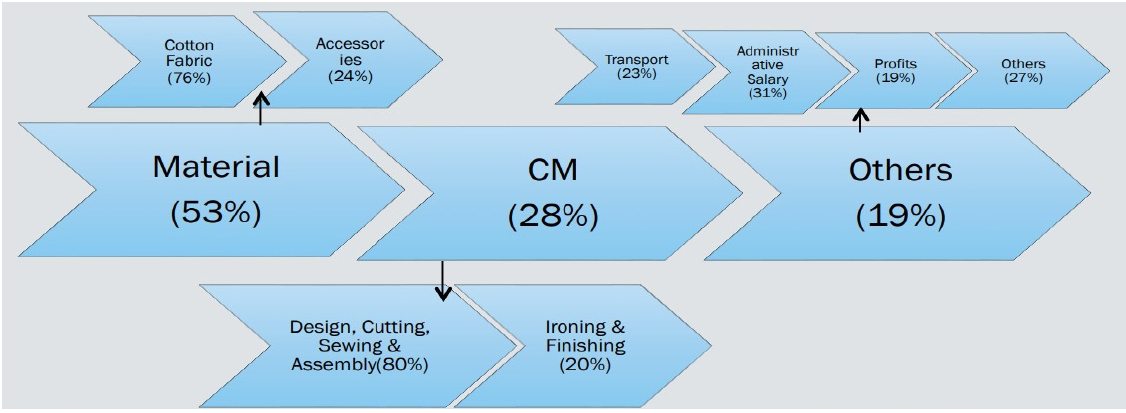
Figure 3: Value Creation Activities by Bangladeshi Denim Jeans Manufacturers (FOB $3 To $6.5) Source: Adapted from “Corporate Governance and Sustainability of the Global Value Chain: Bangladesh Ready-Made Garment Industry”, by Nachum et al., 2017, p.13.